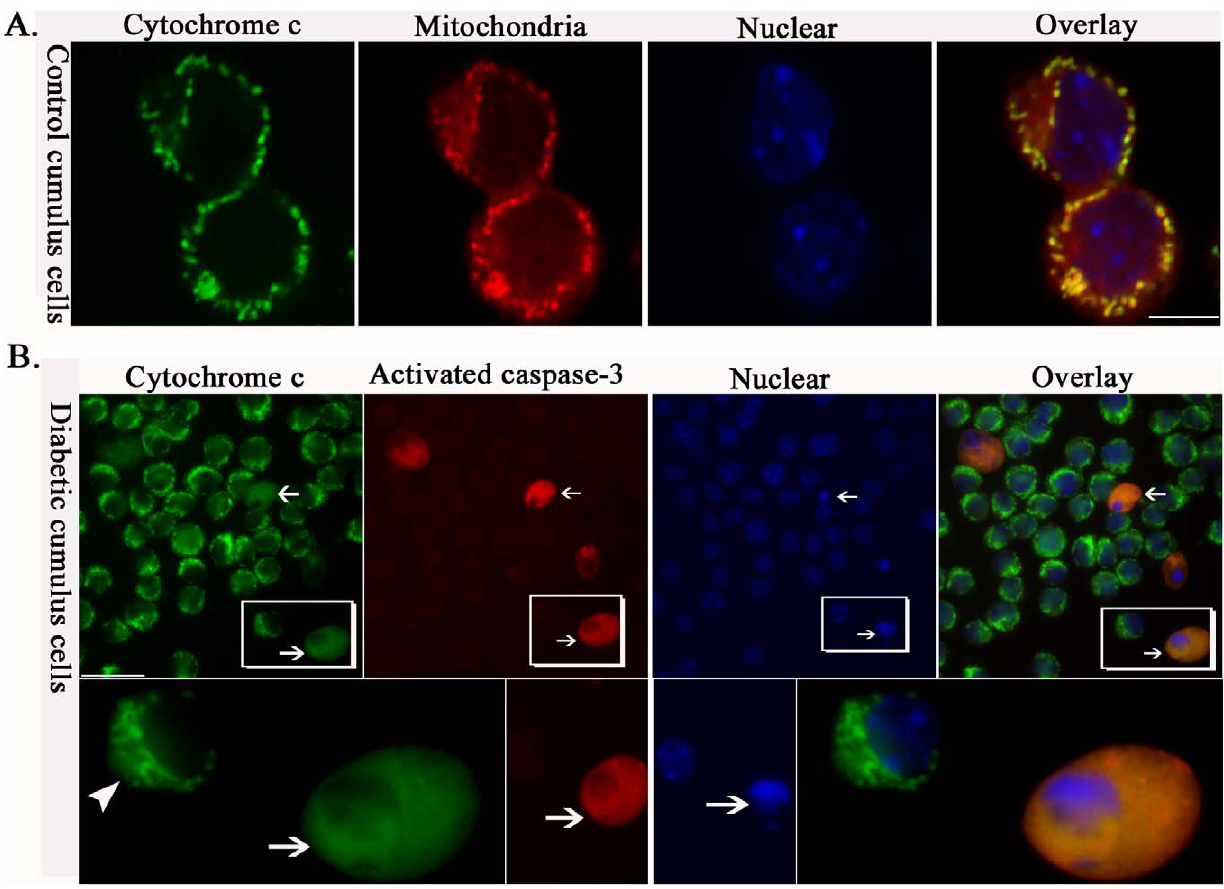
Figure 7. Cytochrome c translocation and caspase-3 activation in apoptotic cumulus cells of diabetic mice. (A) Cumulus-oocyte complexes collected from control mice were stained with cytochrome c antibody and MitoTracker to determine the subcellular localization of cytochrome c (green) and mitochondria (red), and counterstained with DAPI to visualize nuclei (blue). Representative confocal sections of cumulus cells are shown. Cytochrome c shows a punctuate distribution pattern and co-localizes with the mitochondria (yellow) in control cumulus cells. (B) Cumulus-oocyte complexes collected from diabetic mice were stained with cytochrome c antibody (green), activated caspase-3 antibody (red) and DAPI (blue). All apoptotic cumulus cells of diabetic mice (arrows), as evidenced by positive staining of active caspase-3 antibody (red; arrows) and condensed chromatin (blue; arrows), always display diffuse staining of cytochrome c (green; arrows), indicating its translocation from mitochondria to cytoplasm. In contrast, those non-apoptotic cumulus cells of diabetic mice (green, lower panel; arrowheads) stained negatively with active caspase-3 antibody still show mitochondria-localized cytochrome c . Scale bars: 20 m m.